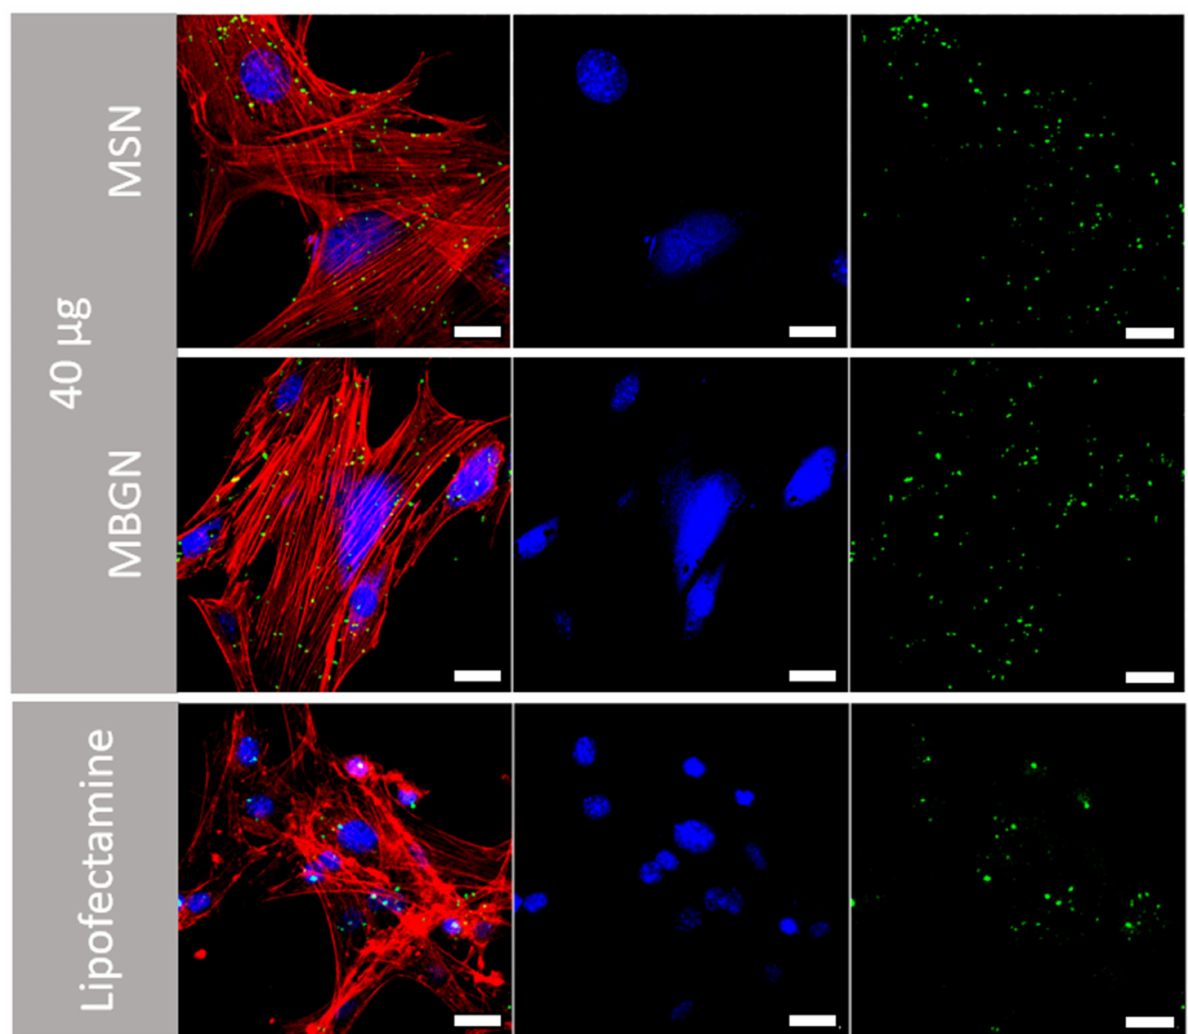
Figure 5. Transfection efficacy of FAM labelled microRNAs by MSN-PEI or MBGN-PEI towards rBMSCs. Representative confocal images of MSN-PEI and MBGN-PEI groups of rBMSCs after transfection with FAM labelled microRNAs (green) using nanoparticles for six hours. The cell nuclei were stained with DAPI (blue) and cell cytoskeletons were stained with Phalloidin (red) (Scale = 20 µ m). Panel labels show the amount of nanoparticles ( µ g). Lipofectamine was used as a positive